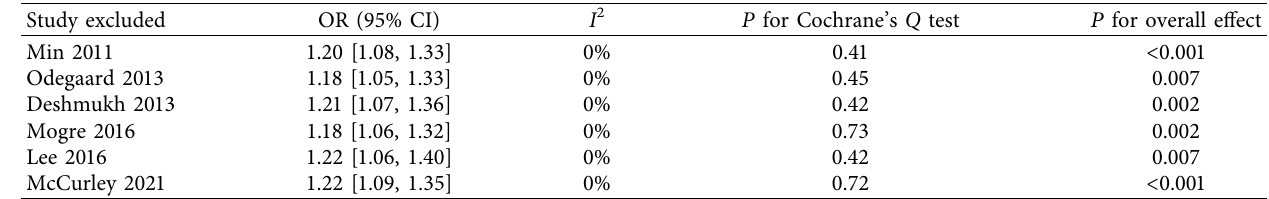
Table 2: Sensitivity analyses.